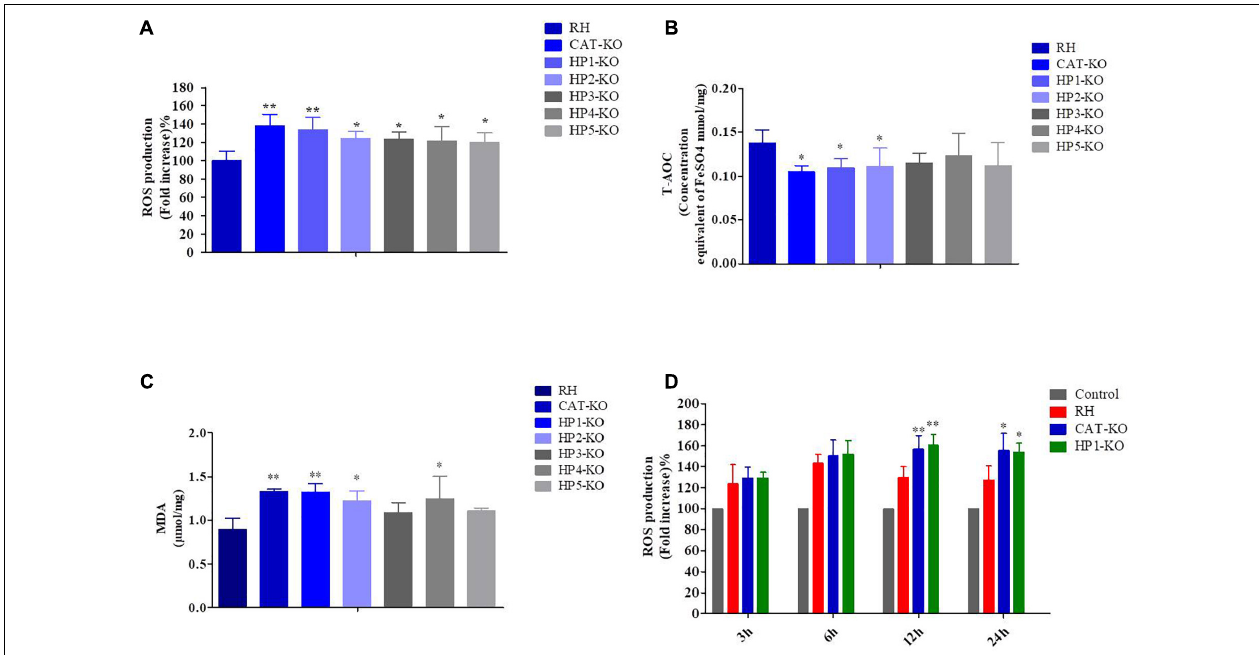
FIGURE 4 | Reactive oxygen species (ROS), total antioxidant capability (T-AOC), and malondialdehyde (MDA) levels in Toxoplasma gondii and reactive oxygen species levels in macrophages. (A) ROS levels in tachyzoites. Data are expressed as a percentage (%) of the ROS level of mutants compared to the ROS level in RH parasites. (B) T-AOC and (C) MDA levels in tachyzoites. All samples were measured in triplicates. (D) ROS levels in macrophages. Data are expressed as a percentage (%) of ROS levels in mutant-infected macrophages compared to that in control macrophages. All samples were measured in triplicates. ** P < 0.01, * P < 0.05 significant changes versus control/RH strain.